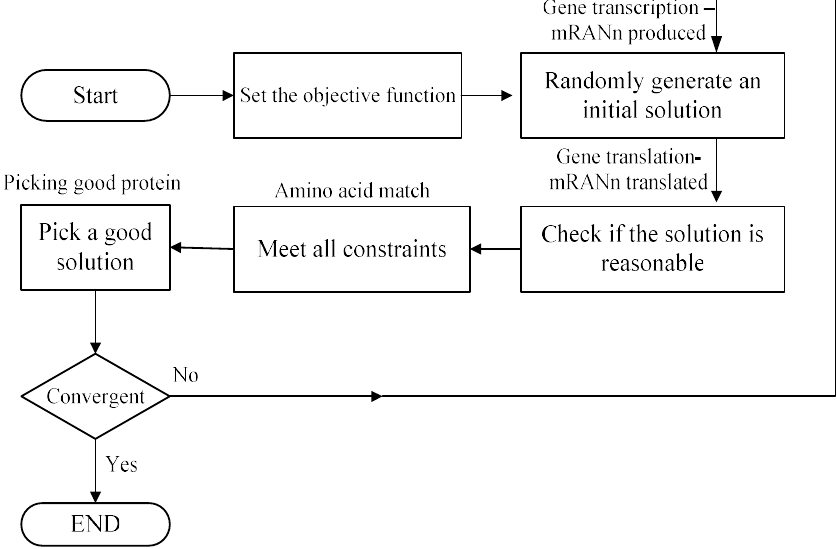
Figure 9. The procedure of the binary proteome algorithm (BPA).